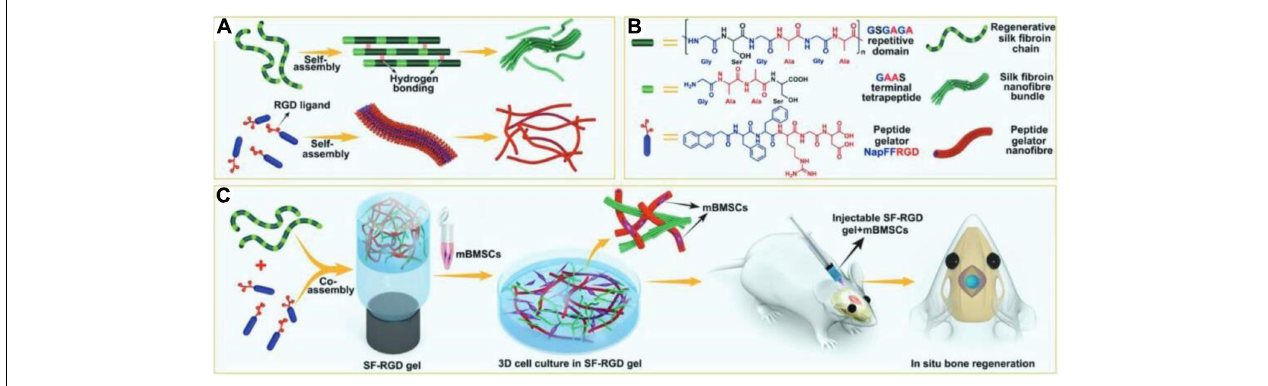
FIGURE 6 | (A,B) Molecular structures and self-assembling properties of peptide gelator and SF for the formation of nanofiber and nanofibril bundle structures. (C) Schematic of preparation process of SF-RGD for bone regeneration in calvarial defect areas of mouse. Reproduced from Yan et al. (2018) with permission from Wiley (Copyright